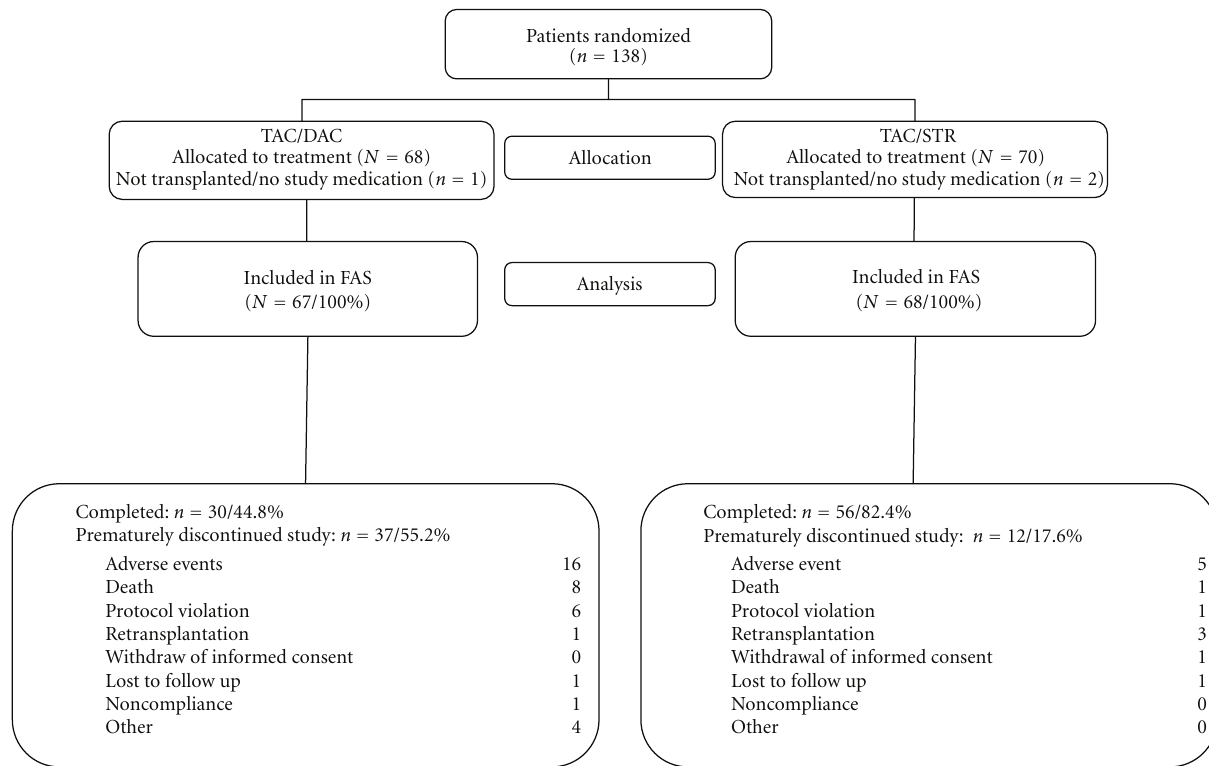
Figure 1: Progress of liver transplant recipients through the phases of the randomized study comparing a tacrolimus-based protocol with and without steroids. The rate of study completion was lower with TAC/DAC than with TAC/STR. Most commonly, patients in the TAC/DAC arm prematurely discontinued the study due to an adverse event. TAC: tacrolimus; DAC: daclizumab; STR: steroids; FAS: full analysis set; PAS: primary analysis